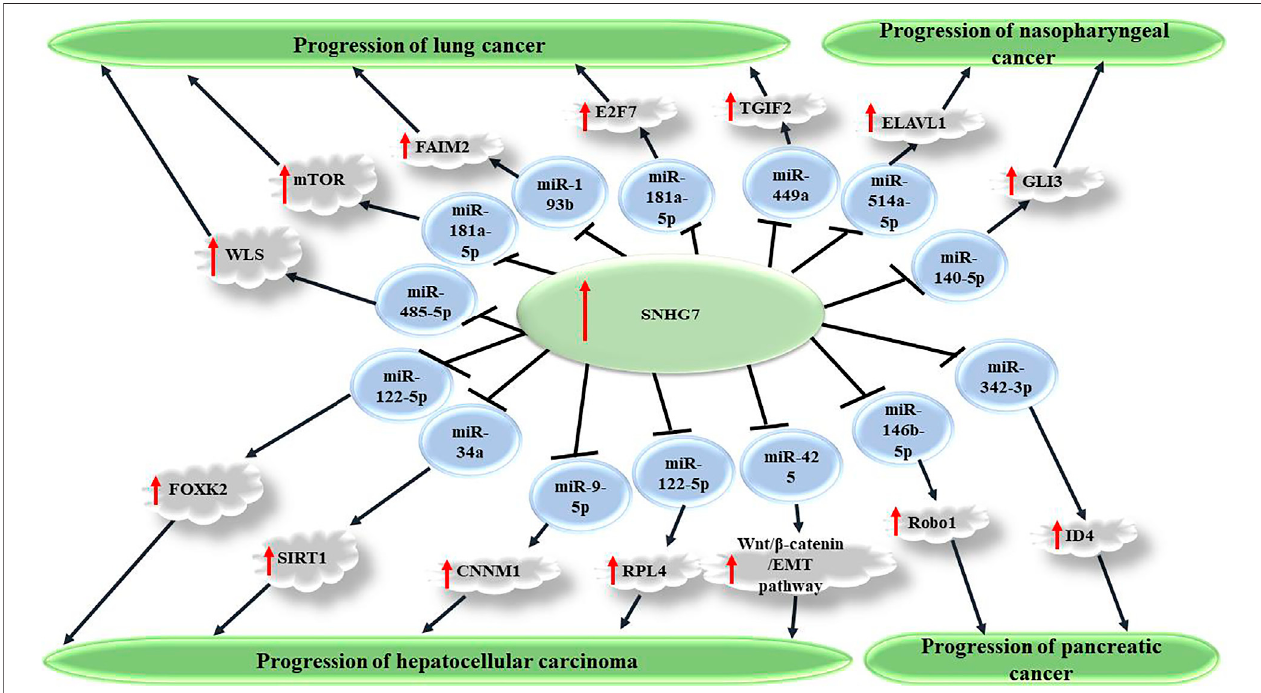
FIGURE 1 | SNHG7 promotes carcinogenesis via sponging miRNAs and consequently upregulating several transcription factors. Through repression of target miRNAs, including miR-449a, miR-181a-5p, miR-193b, and miR-485-5p, SNHG7 causes increased expression of TGIF2, mTOR, FAIM2, and WLS factors, which consequently promote malignant features of cancer cells and enhanced carcinogenesis in non-small cell lung carcinoma. SNHG7 also plays a role in progression of several other cancers, including nasopharyngeal, pancreatic, and hepatocellular carcinoma.